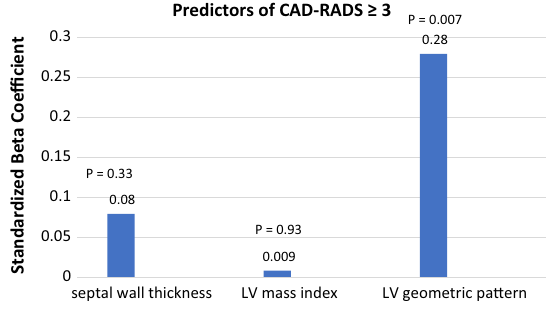
Fig. 7 Regression analysis to predict significant CAD, CAD-RADS